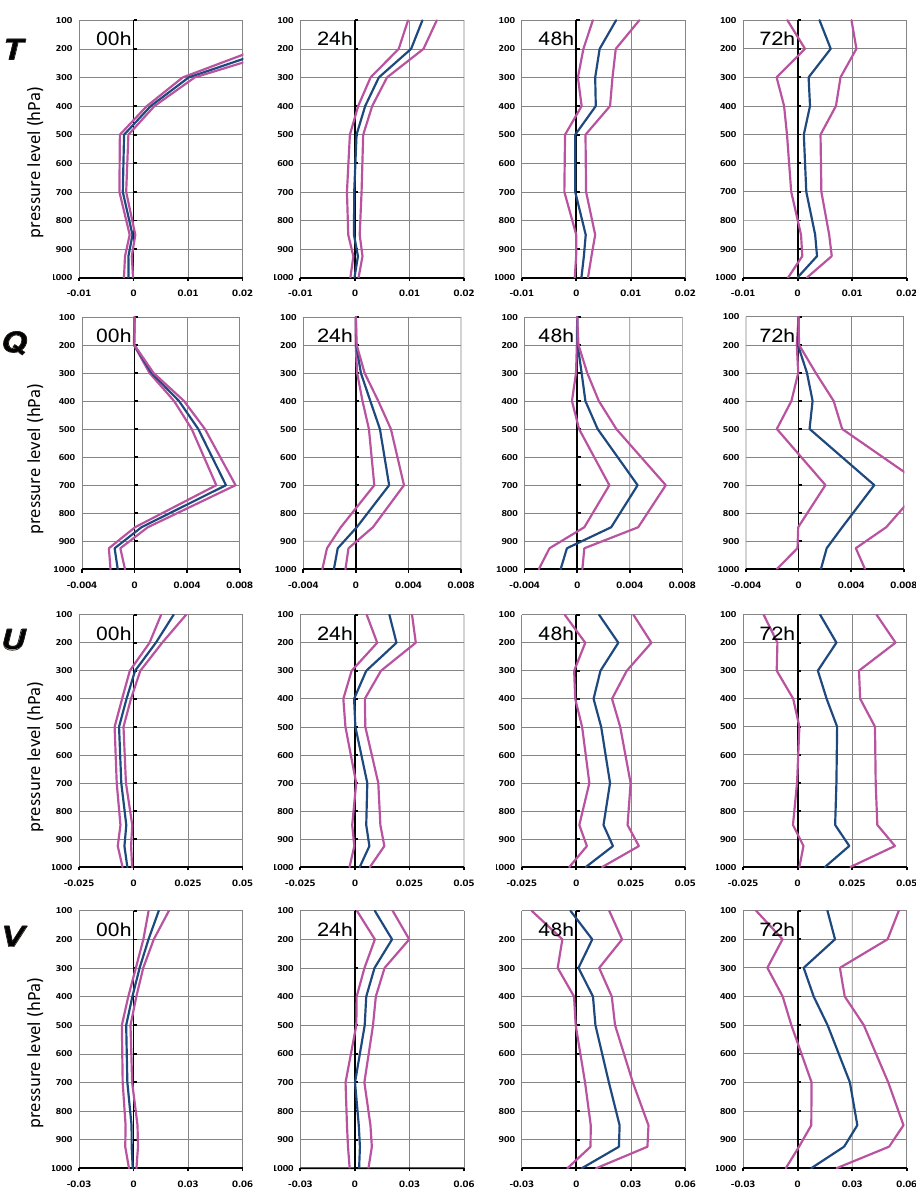
Figure 3. Mean difference in RMSE between PNG and PWG (blue line). From top to bottom: temperature ( T , unit: K), mixing ratio of water vapor ( Q , unit: kgkg − 1 ) , zonal wind ( U , unit: ms − 1 ) and meridional wind ( V , unit: ms − 1 ) . The vertical axis is pressure level (unit: hPa) and the area enclosed by the pink lines in each panel is the 95% confidence